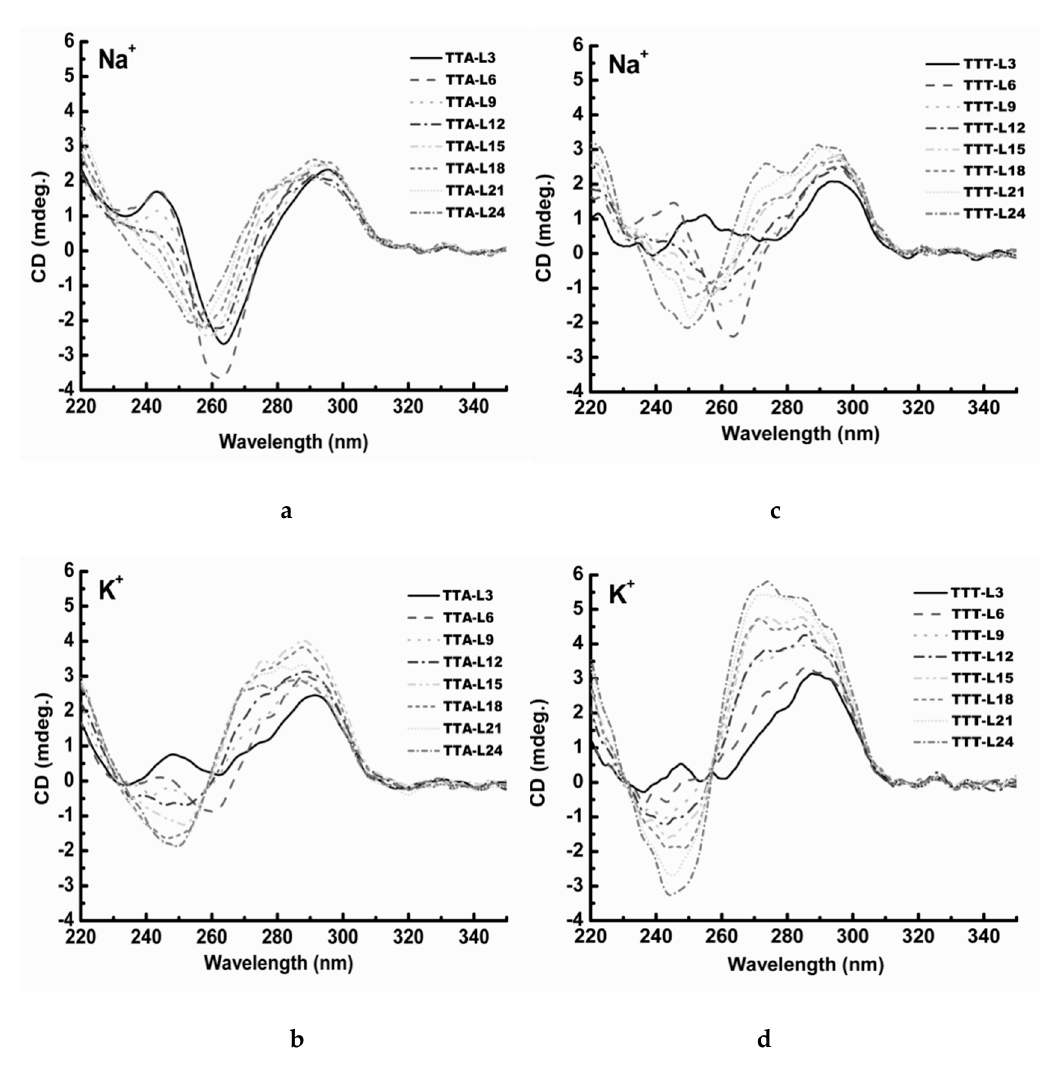
Figure 2. Circular dichroism (CD) spectra of TTA series and TTT series. ( a ) TTA series in 100 mM Na + solution; ( b ) TTA series in 100 mM K + solution; ( c ) TTT series in 100 mM Na + solution; ( d ) TTT series in 100 mM K + solution.